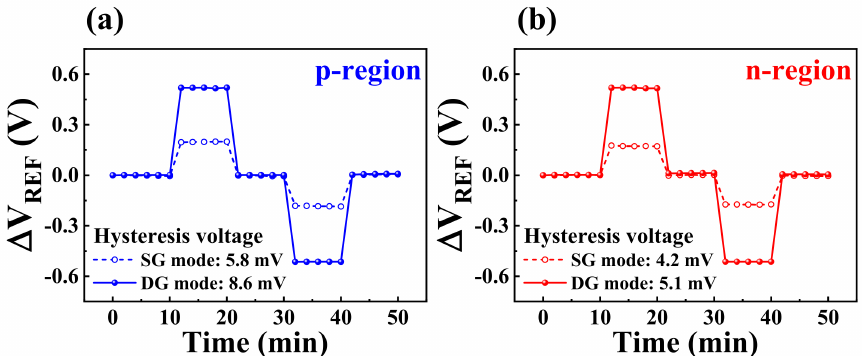
Figure 7. Hysteresis effect of the ambipolar DG ISFET in the ( a ) p region and ( b ) n region for three different buffer solutions with pH values of 4, 7, and 10. The open and closed circles represent ∆ V REF in the SG and DG sensing modes,